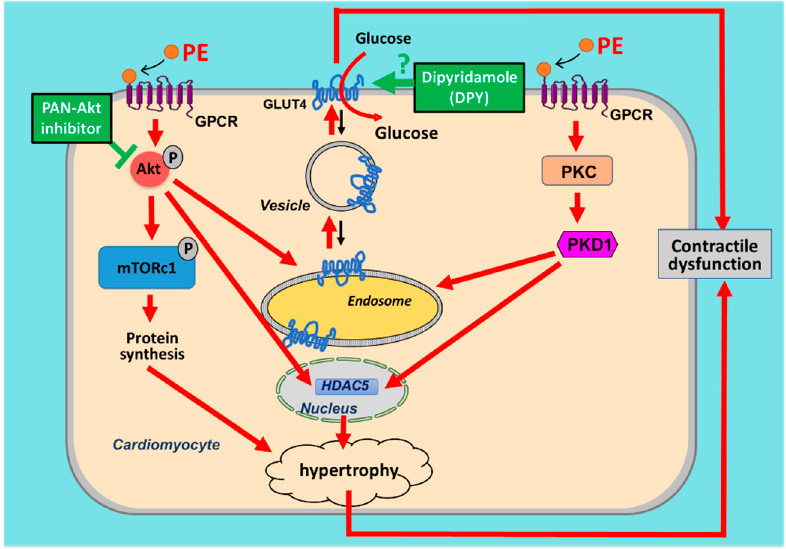
Figure 7. Integration of mechanisms of the phenylephrine (PE)-induced increase in glucose uptake and hypertrophy in cardiomyocytes—a hypothetical scheme. PE induces both activation of the Akt and protein kinase D (PKD1) signaling pathways. The PE-induced phosphorylation of Akt and of PKD1 leads to increased translocation of the main glucose transporter GLUT4 from the endosomes to the cell surface, resulting in increased glucose uptake. At the same time, activated Akt and PKD1 lead to the phosphorylation and nuclear export of HDAC5, resulting in release and activation of hypertrophic transcription factors. Additionally, PE-induced Akt phosphorylation causes activation of mTOR, a major regulator of protein synthesis. Both the PE- induced increase in glucose uptake and hypertrophy contribute to contractile alterations. Treatment of cardiomyocytes with PAN-Akt inhibitor or DPY inhibit GLUT4 translocation or GLUT4-mediated glucose transport, respectively, and protect the cell from contractile alterations. Since DPY treatment does not restore the PE-induced increases in protein synthesis and hypertrophic markers, yet restores contractile properties, it follows that targeting metabolism, independent from hypertrophy, forms a promising strategic approach to prevent hypertrophy-induced contractile dysfunction. The arrows indicate the directions. The —I symbol indicates